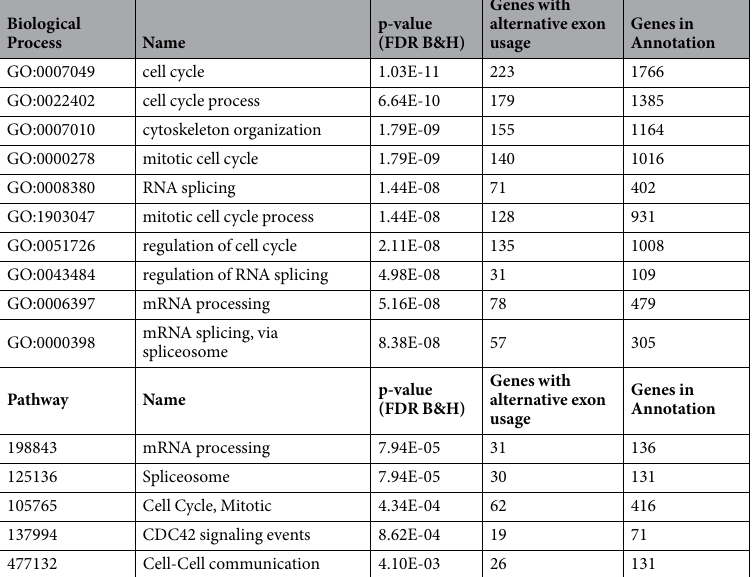
Table 4. Significantly enriched biological processes and pathways affected by alternative exon usage common to all three tumor